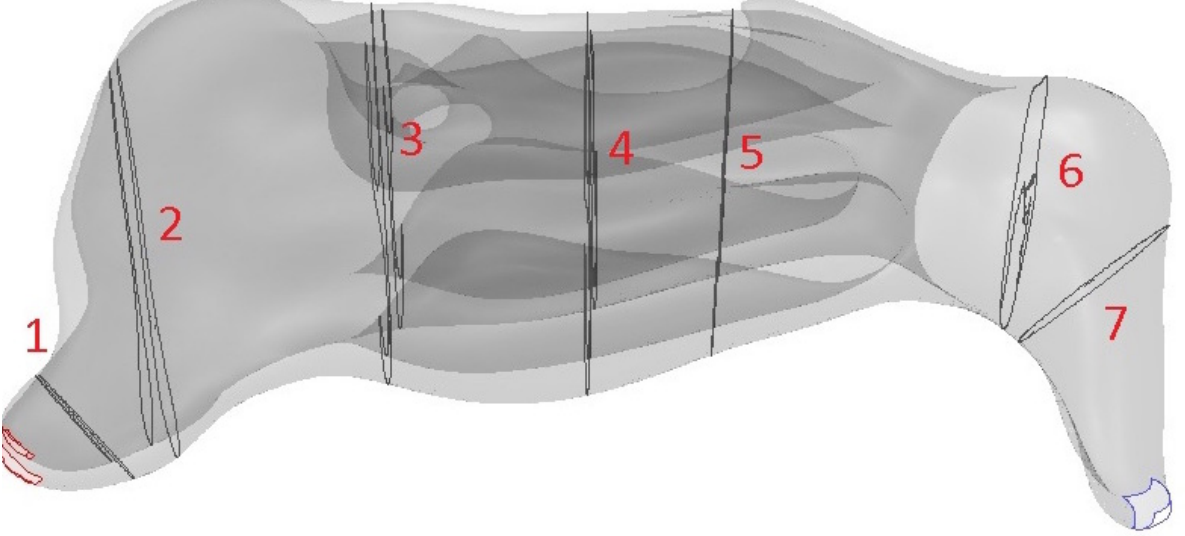
Figure 4. Model simulations of frontal sections 1–7 in the nasal cavity.